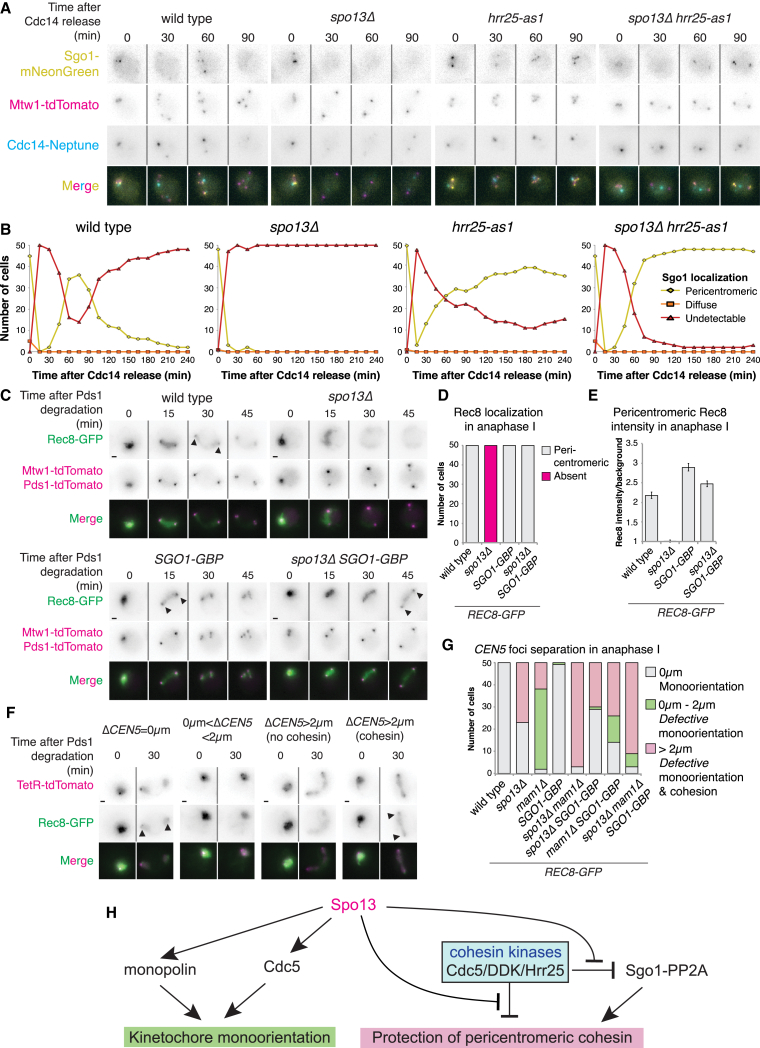
Contribution of Post-Metaphase I Sgo1 Loss to Defective Cohesion in spo13Δ Cells(A and B) Time lapse of Sgo1 returning to the pericentromere after anaphase I onset. (A) Representative images. (B) Scoring of Sgo1 localization in 50 cells for 4 h after initial Cdc14 release.(C–E) Sgo1 tethering to Rec8. (C) Representative images. Scale bars, 1 μm. Arrows indicate pericentromeric cohesin. (D) The presence of pericentromeric cohesin in anaphase I was scored in 50 cells. (E) Average intensity of pericentromeric Rec8-GFP with standard error bars.(F and G) Sister chromatid cohesion upon tethering of Sgo1 to Rec8. (F) Representative images from time-lapse. Scale bars, 1 μm. Arrows indicate pericentromeric cohesin. (G) Categories of heterozygous CEN5-GFP at anaphase I onset scored by measuring the maximum distance between two TetR-tdTomato foci within two time points after bulk Rec8 cleavage for 50 cells per strain.(H) Model for regulation of meiosis I chromosome segregation by Spo13. For details, see text.See also Figures S6 and S7.